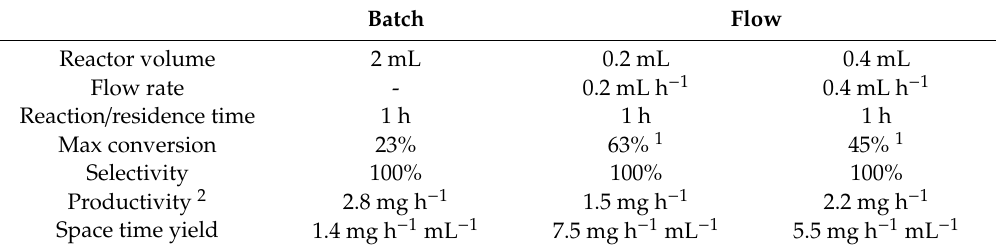
Table 3. Comparison of di ff erent reaction parameters and results obtained from flow and batch experiments (see Sections 3.4 and 3.8). In all experiments, the same total amount of catalyst was used.